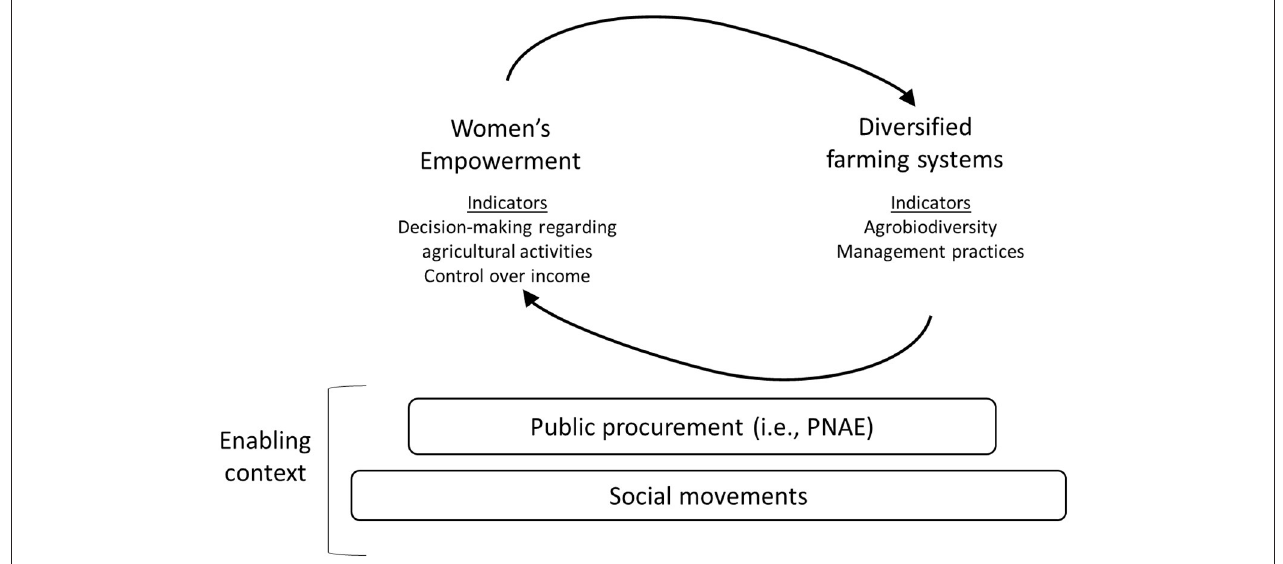
FIGURE 1 | Focusing on targeted public food procurement programs that support farm diversification, we hypothesize that public procurement programs create an enabling social context that bolsters positive feedbacks between women’s empowerment and crop diversification on farms; and that this enabling context is amplified by social